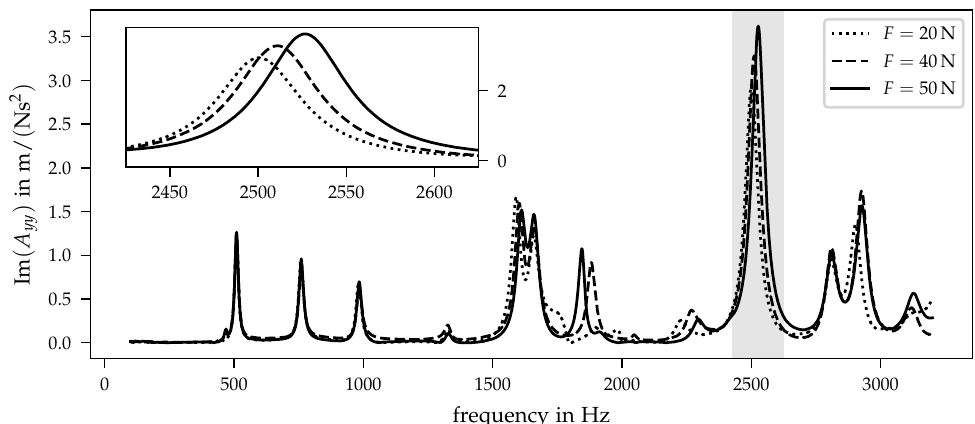
Figure 7. Imaginary part of inertance A yy for three different preloads and the auxiliary construction in position 2. The small diagram in the left corner shows the inertances in the frequency range from 2425Hz to